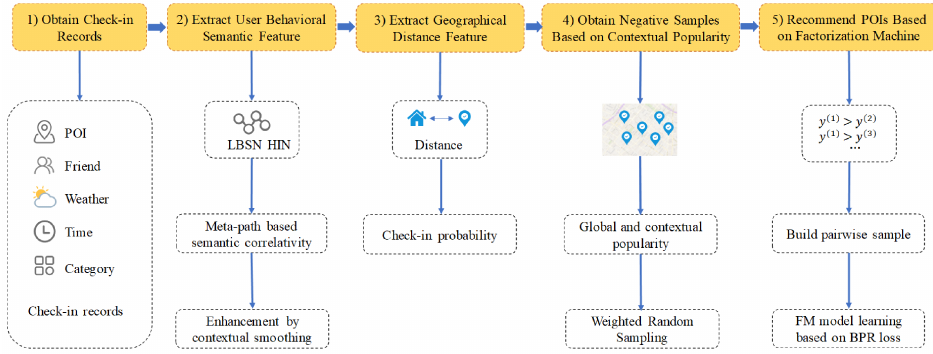
Figure 3. The context-specific POI recommendation